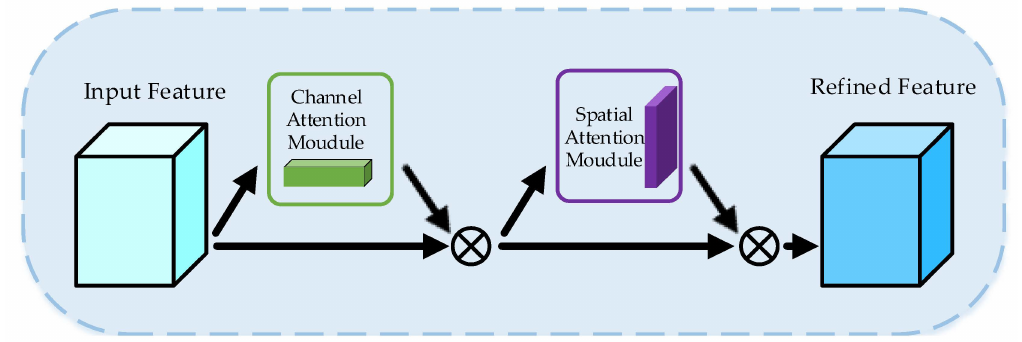
Figure 7. Channel Spatial Attention